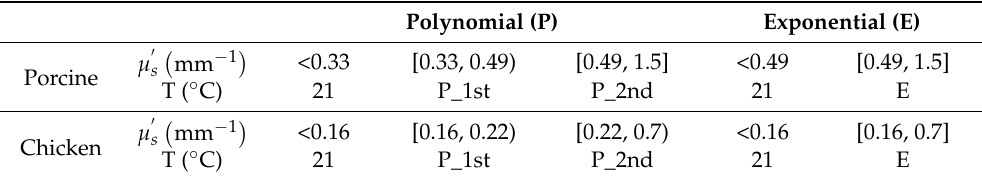
Table 3. Mapping between µ (cid:48) s and temperature (T) (P_1st: fittings using polynomial model in the 1st stage; P_2nd: fittings using polynomial model in the 2nd